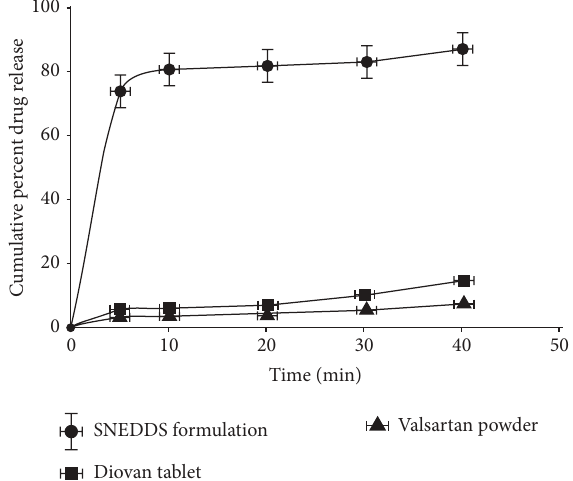
Figure 3: Comparison of in vitro drug release profile of SNEDDS containing valsartan powder with valsartan